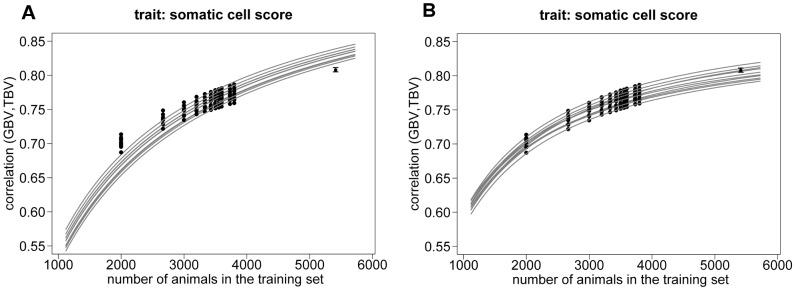
Predicted and empirical values of  when extrapolating the accuracy.Empirical values of  (black dots) of the ten replicates with different k-fold scenarios using 4′000 individuals and of the 20-fold runs of the fifty replicates using 5′698 Holstein-Friesian animals in total. Expected values (grey lines) use the number of  derived with a Maximum-Likelihood approach in the original equation of Daetwyler et al. (2010) (D1, Figure 7A) and in the modified equation of Daetwyler et al. (2010) (D2, Figure 7B).